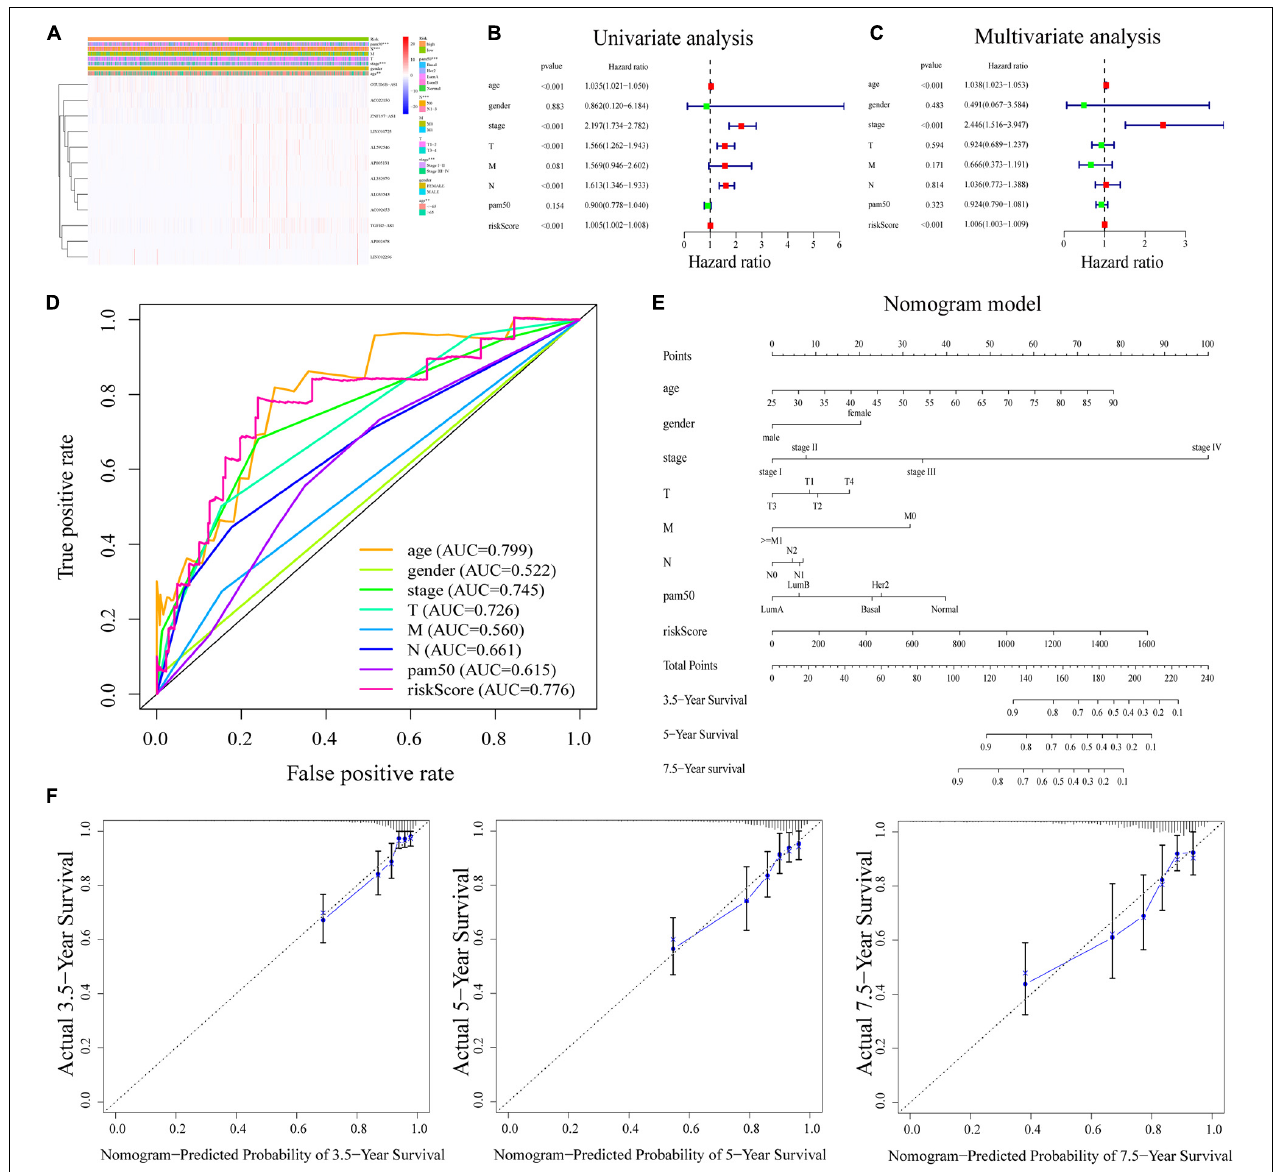
FIGURE 4 | (A) Heatmap of the association between the expression levels of the 12 m 6 A-related lncRNAs and clinicopathological features in The Cancer Genome Atlas (TCGA) dataset. (B,C) Risk score was an independent prognostic predictor by univariate and multivariate analyses. (D) ROC curves for the risk score, age, gender, stage, T, M, N, and PAM50. (E) Nomogram based on risk score, age, gender, stage, T, M, N, and PAM50. (F) Calibration plots of the nomogram for predicting the probability of OS at 3.5, 5, and 7.5 years. ROC, receiver operating characteristic; lncRNAs, long non-coding RNAs.